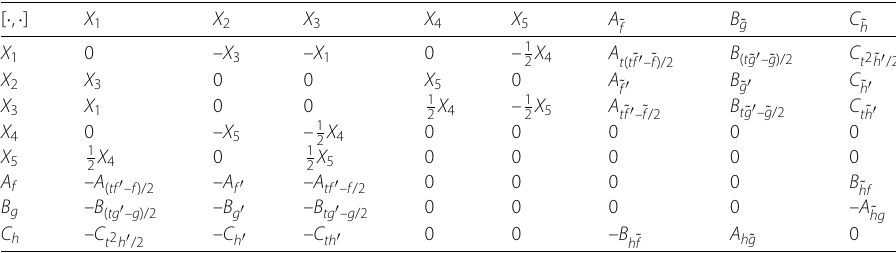
Table 2 The commutator table of L ( G